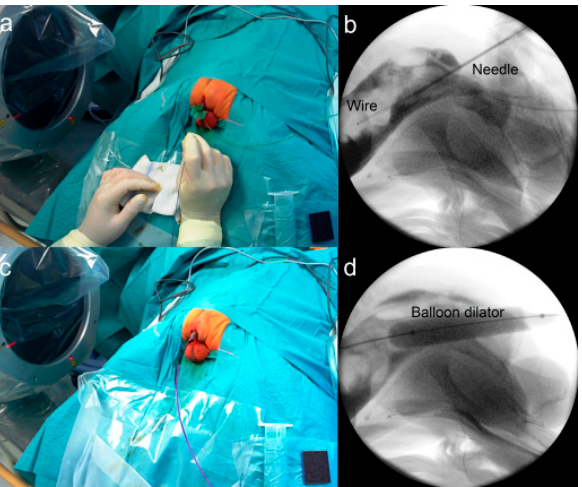
Figure 2. Technique of iPARP. The needle and guidewire are introduced into the rectum through the sphincter complex ( a ) under fluoroscopic guidance ( b ). A balloon dilator is advanced over the guidewire ( c ) to dilate the tract ( d ).